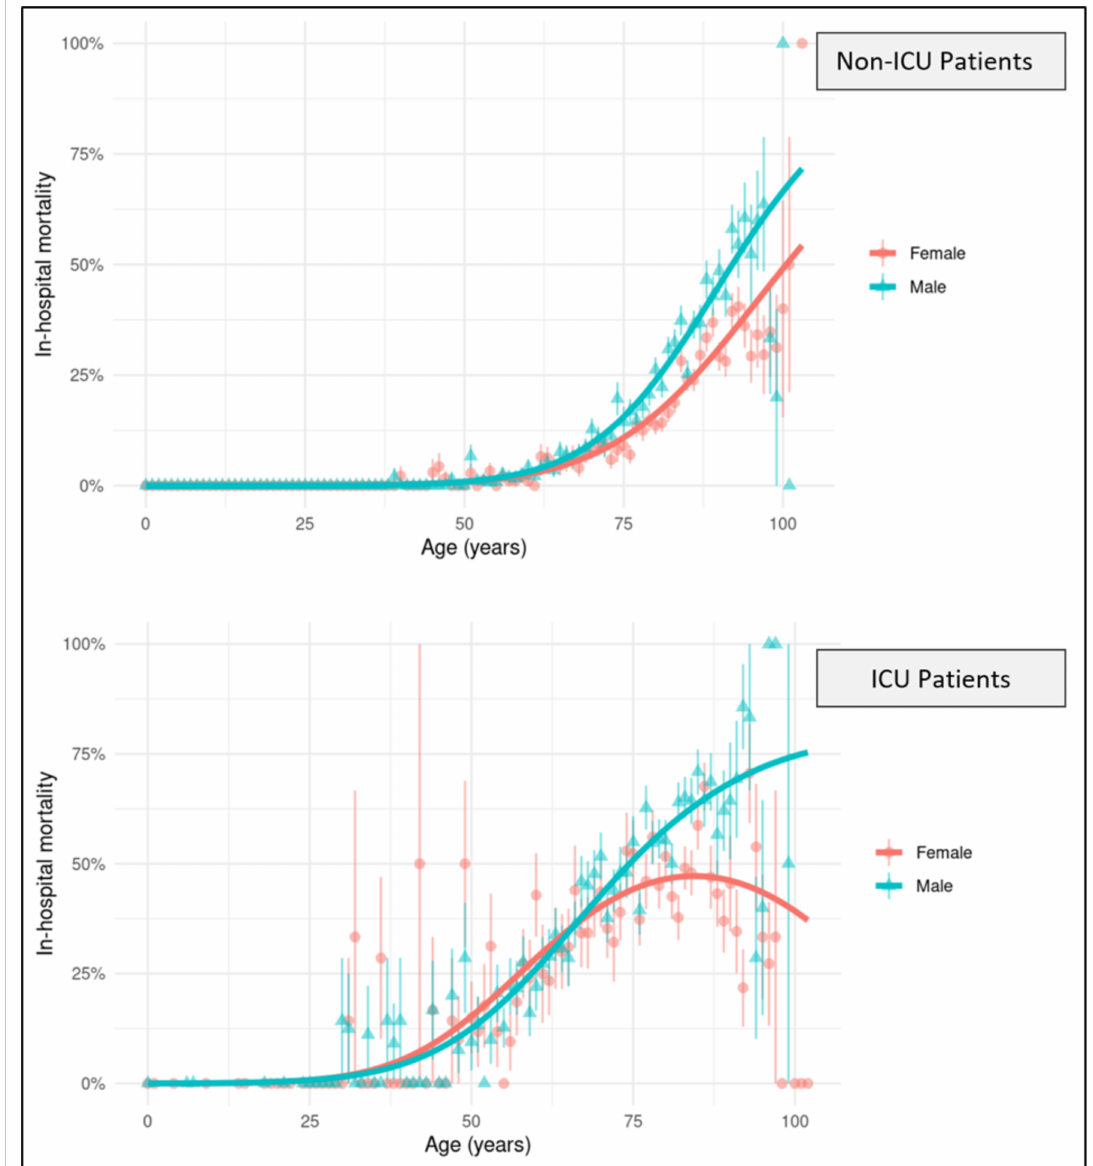
Figure 2. Average In-Hospital Mortality of Males (Circles) and Females (Triangles). Error bars represent standard errors. The curves show the model